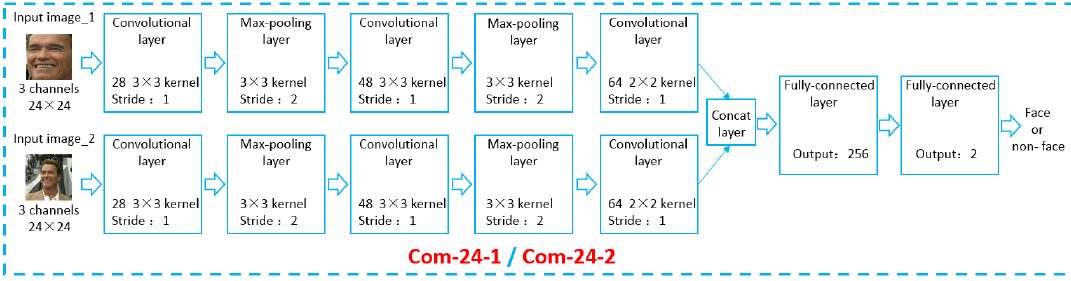
Figure 7. The CNN structure of Com-24-1 and Com-24-2.